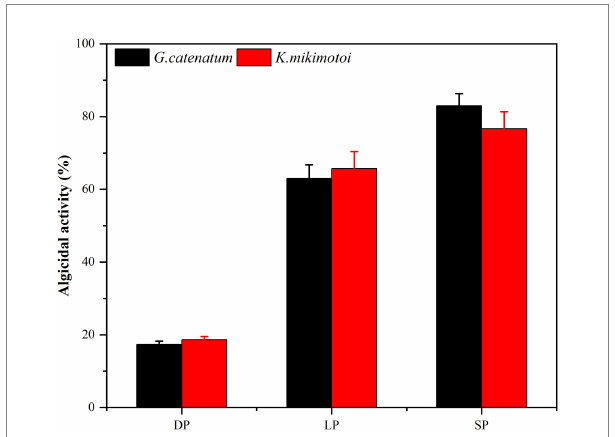
FIGURE 2 Comparison of the 24 h-algicidal activity of the growth bacterial solution at different growth phases (LP-Logarithmic Phase; SP- Stationary Phase; DP-Death Phase).